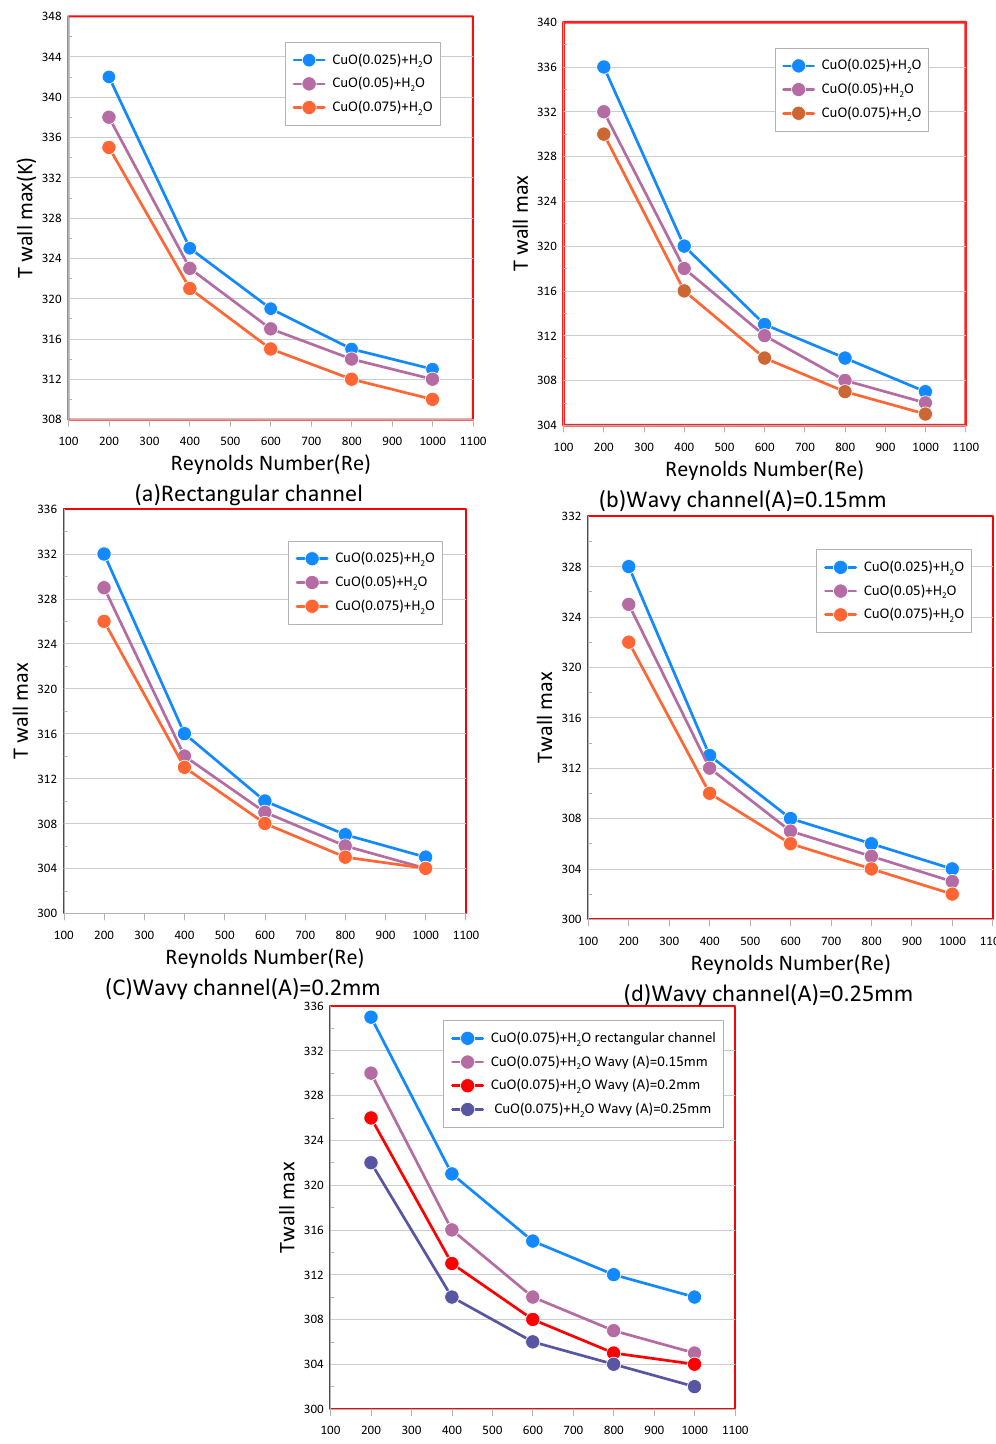
Figure 19. Show the relation between the max wall temperature and a Reynolds number of different types of mini channel heat